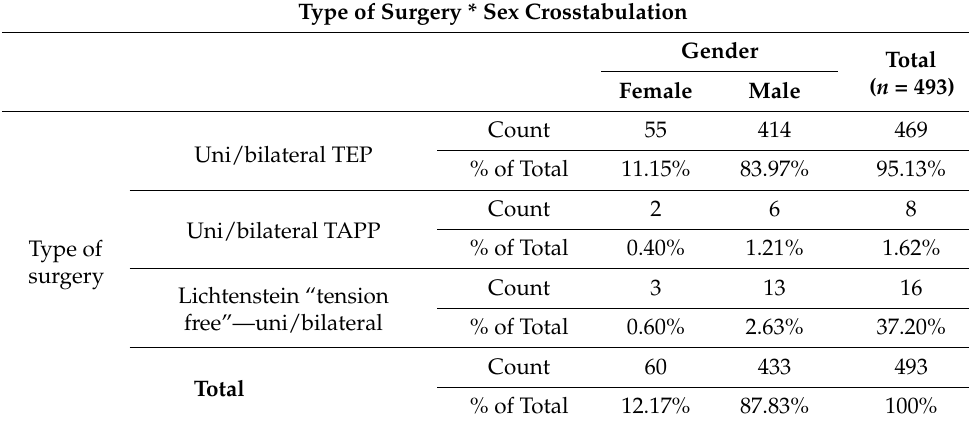
Table 4. Type of surgery performed according to the patient’s